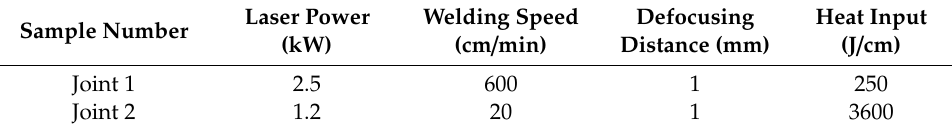
Laser Power Welding Speed Defocusing Heat (kW) (cm / min) Distance (mm)